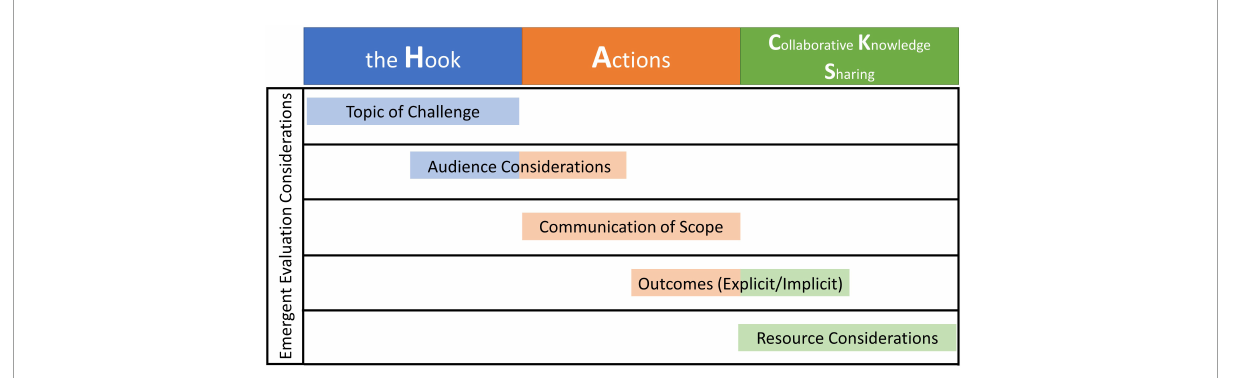
FIGURE2 Emergent evaluation considerations mapped to the three hackathon consideration themes.